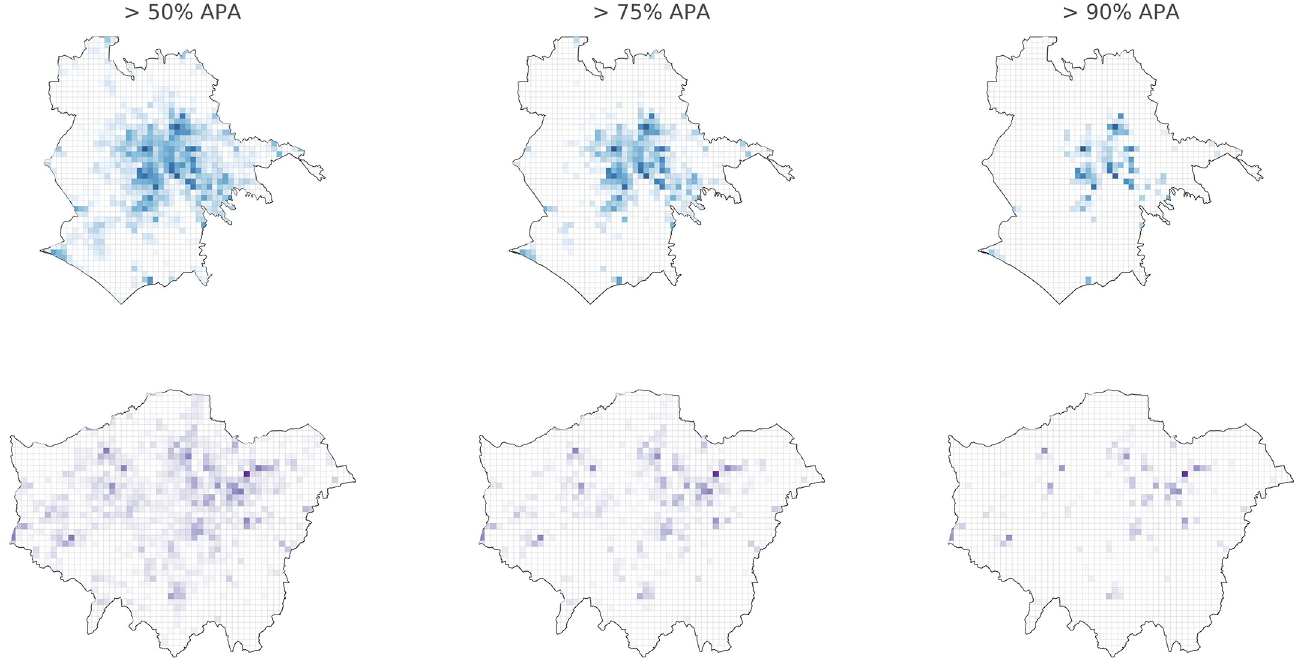
Fig 8. Hotspot locations with APA values greater than the 50th, 75th, and 90th percentiles in (a) Rome and (b) London.